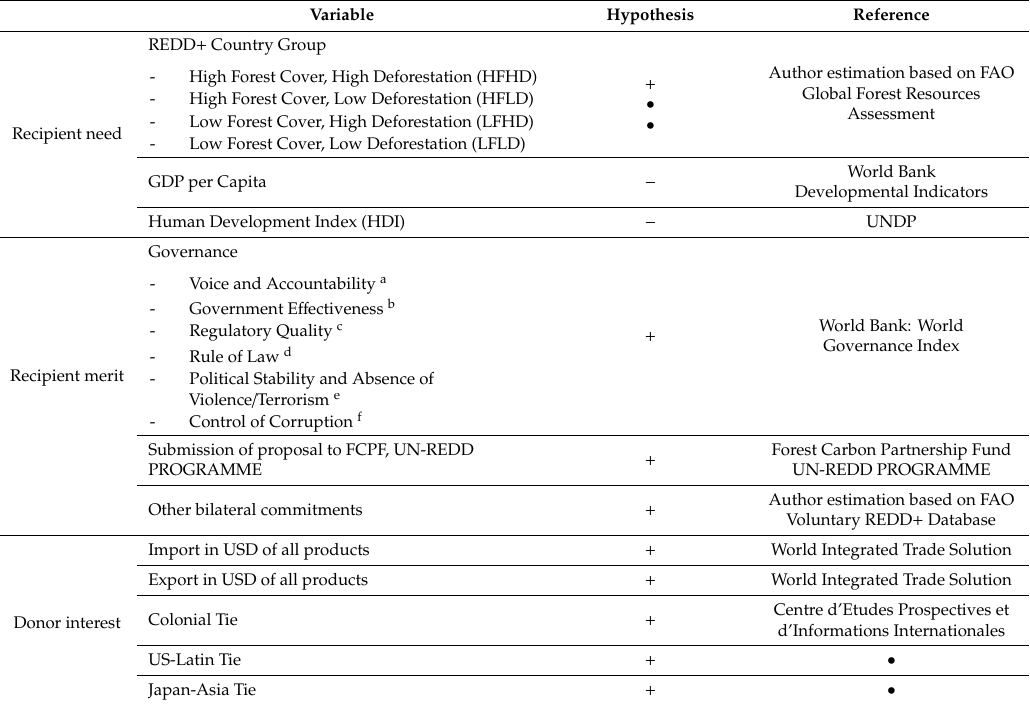
Table 3. Variables of the